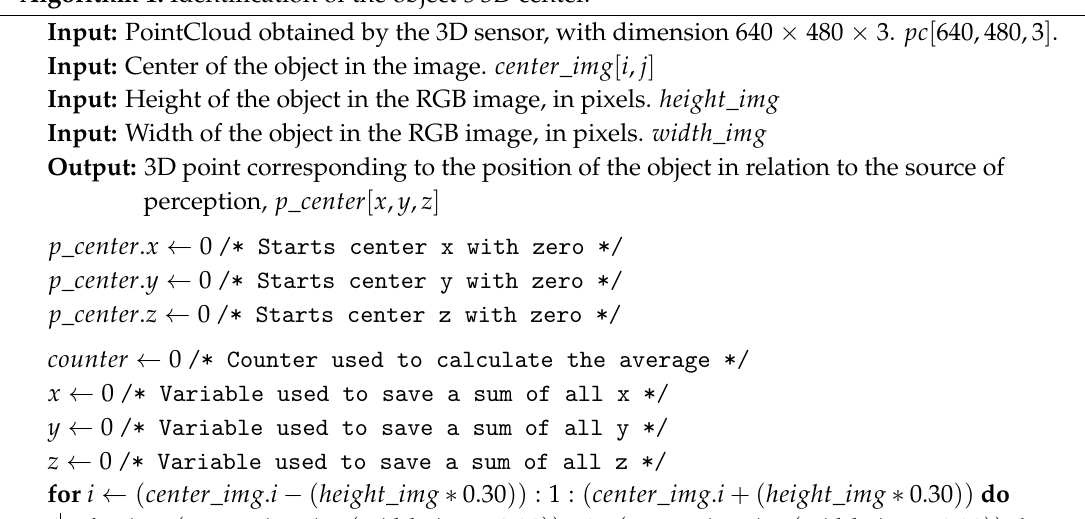
Algorithm 1: Identification of the object’s 3D